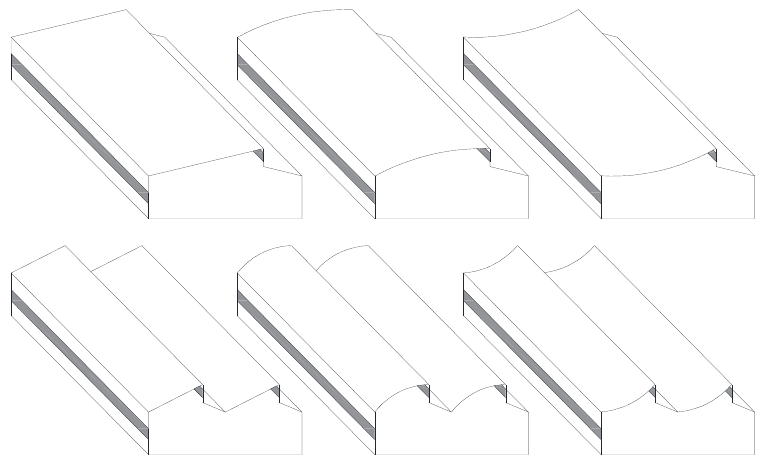
Figure 4. The different roof geometries, including straight, concave, and convex roof geometries, and number of spans, studied by Per é n et al.